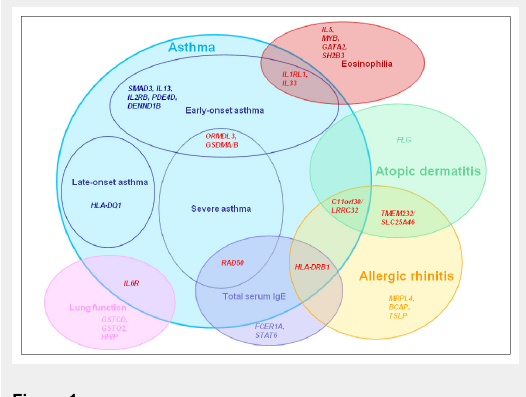
Major susceptibility loci for allergic diseases as identified by GWAS (Venn approach diagram). Genetic loci associated with different subphenotypes are shown in red.